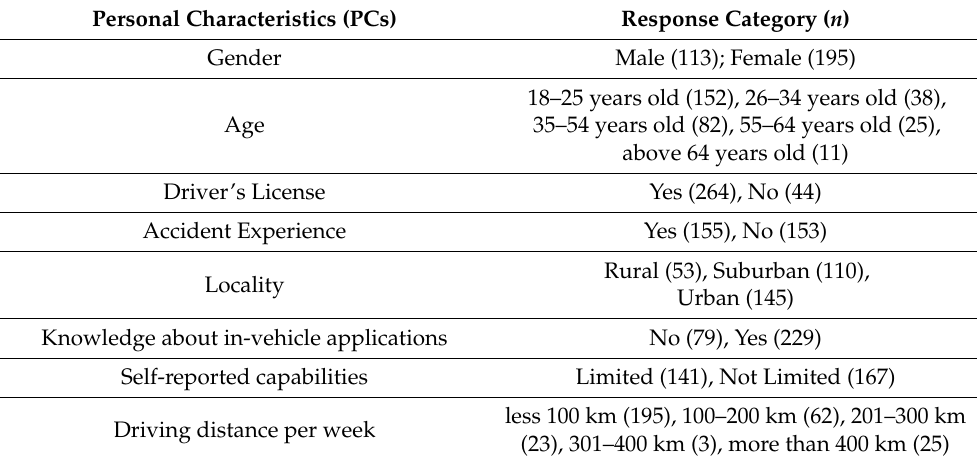
Table 7. Details of respondents ( n = 308).